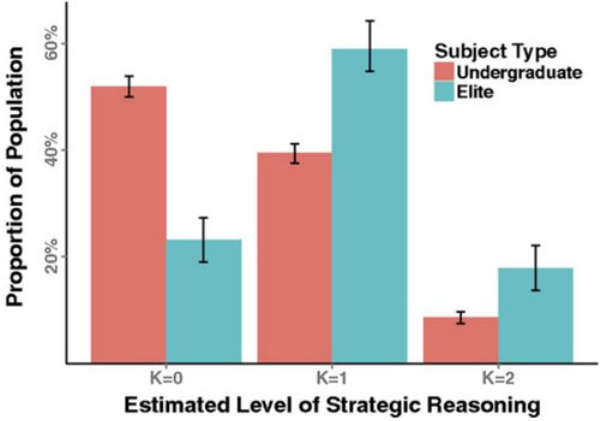
Figure 1. Population differences between elites and undergraduates on strategic reasoning. Bars are sample means/proportions. Vertical lines are bootstrapped Standard